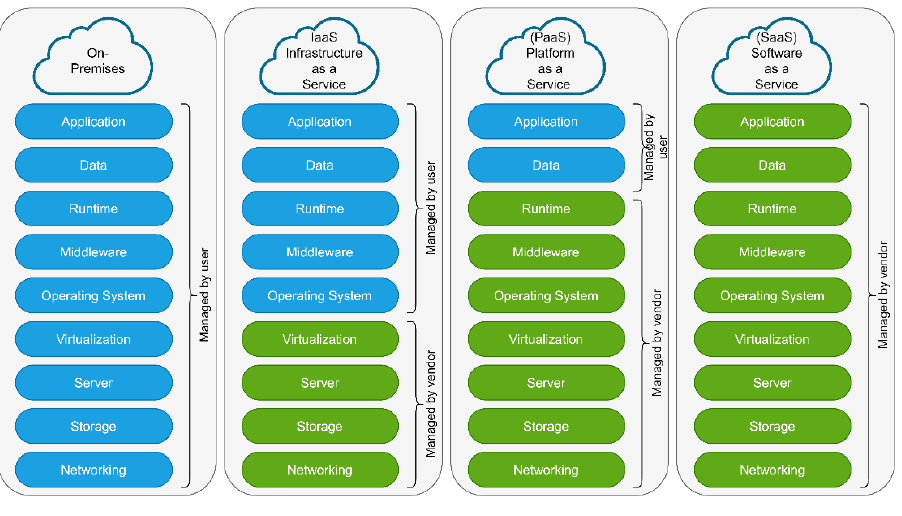
Figure 1. IaaS-PaaS-SaaS comparison [4].